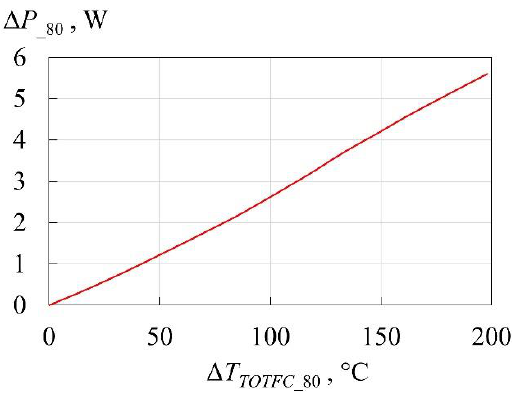
Figure 7. The dependence of ∆ P _80 on ∆ T TOTFC _80 at various ∆ ν (the wavelength of laser radiation is 980 nm, the inner vein diameter is 5 mm).